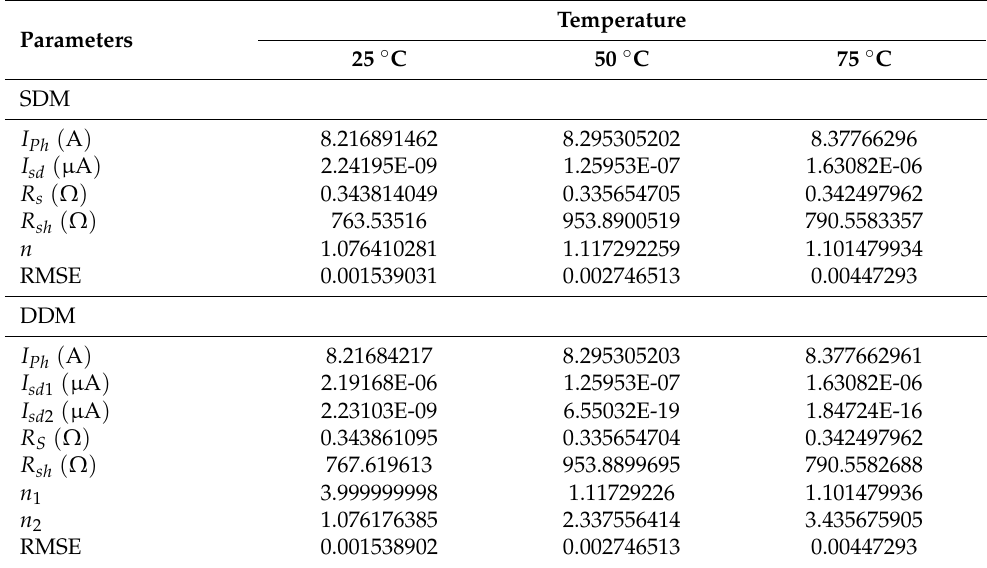
Table 17. Optimal parameters with various temperatures under 1000 irradiance on KC200GT.